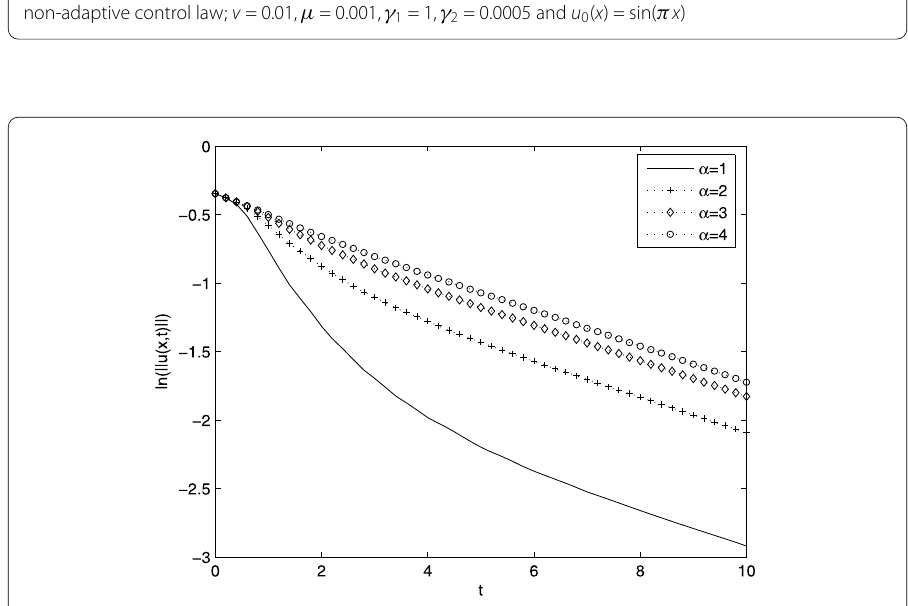
Figure 3 The natural logarithm of the L 2 -norm of u ( x , t ), ln( (cid:7) u ( x , t ) (cid:7) ), versus time for various values of α when using the first nonlinear non-adaptive control law; v = 0.01, μ = 0.001, γ 1 = 1, γ 2 = 0.0005 and u 0 ( x ) = sin( π x )